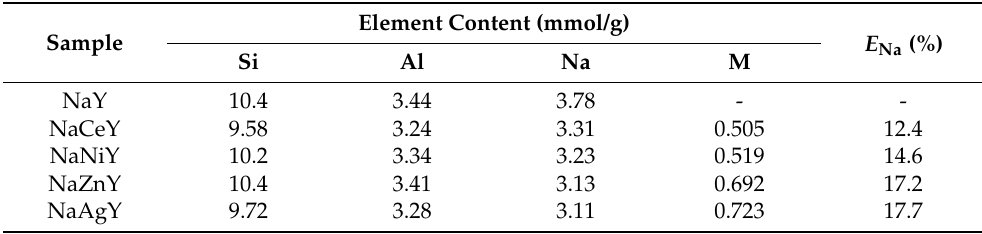
Table 4. Elemental contents and E Na of different Y